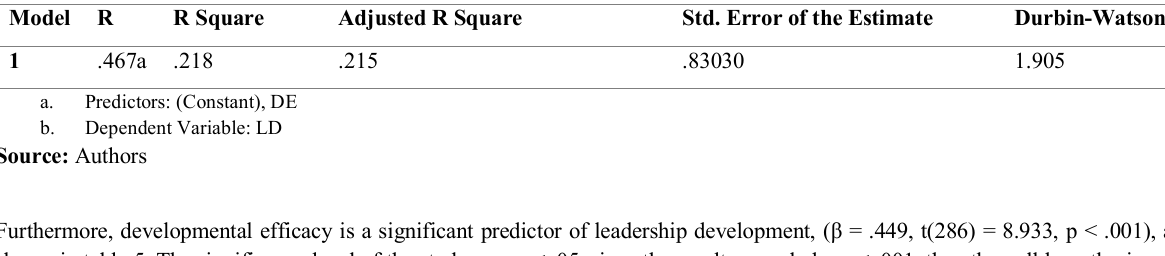
Table 4 : ANOVA for Regression of LD against DE